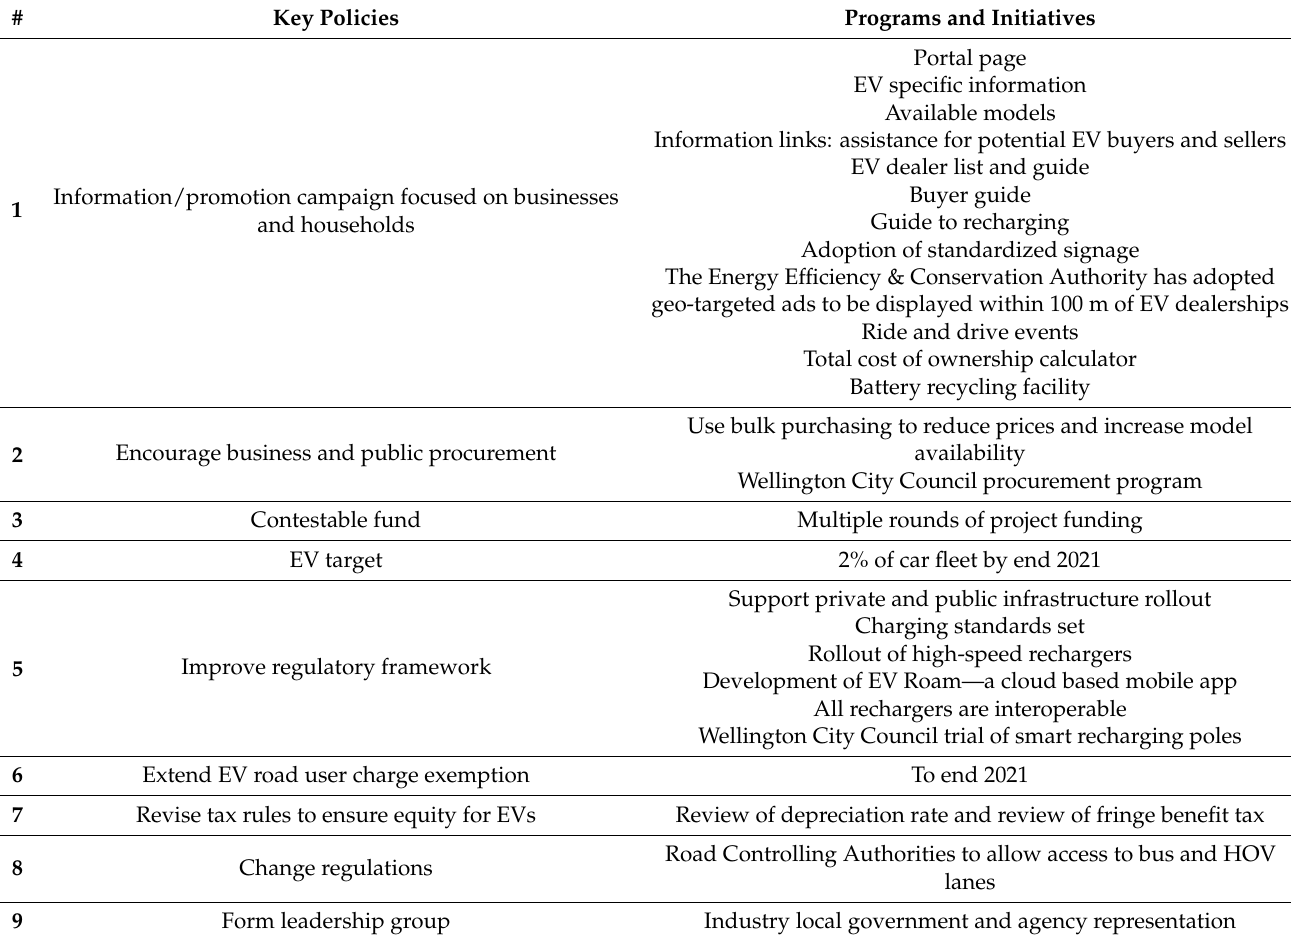
Table 1. New Zealand government key electric vehicle policies 2016. Sources: